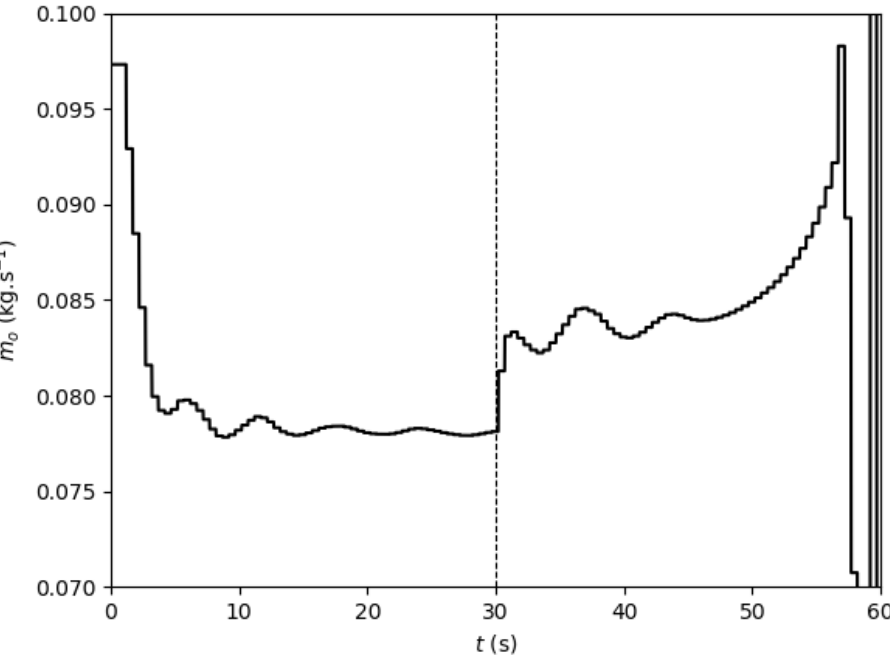
Figure 28. Oxidizer mass flow rate profile, feedback with downgraded regulation law, case 2. Figures 29–32 present the results of the simulation case 3 with the complete regulation law. than 1 N during all the test. The mixture ratio varies between 2.3 and 2.36 from 5 s to 50 s.